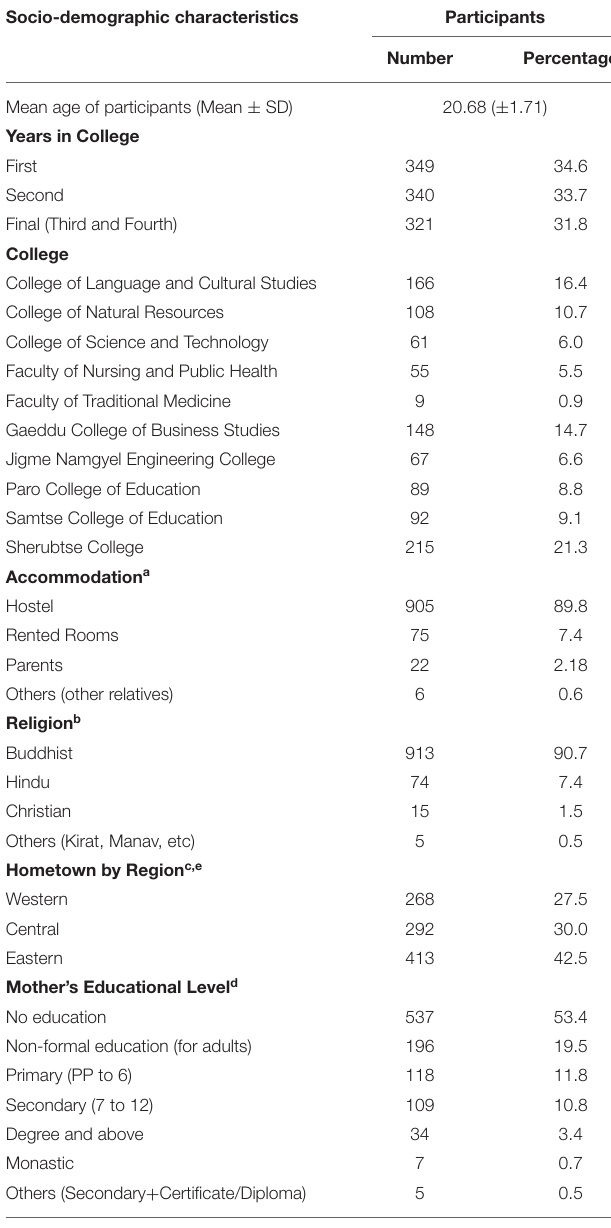
TABLE 1 | Socio-demographic characteristics of female college students in the study ( n = 1,010). Socio-demographic